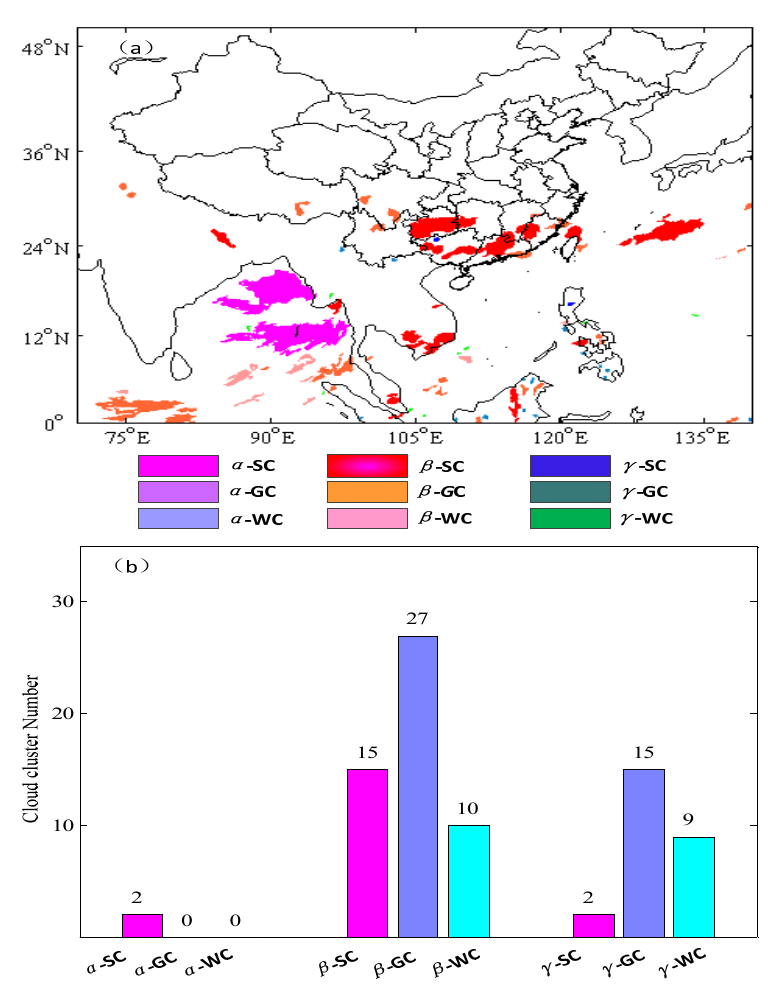
Figure 8. Classification of convective cloud clusters ( a ) and its statistical result ( b ).